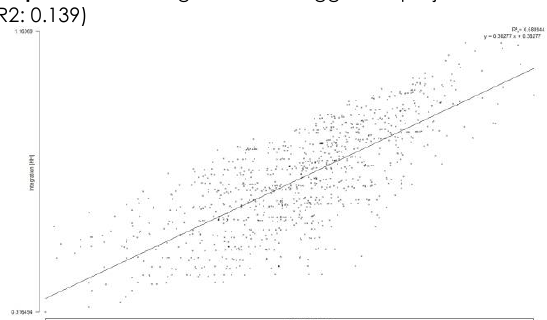
Graph 3. Rn Scattergram in the suggested project, value (R2: